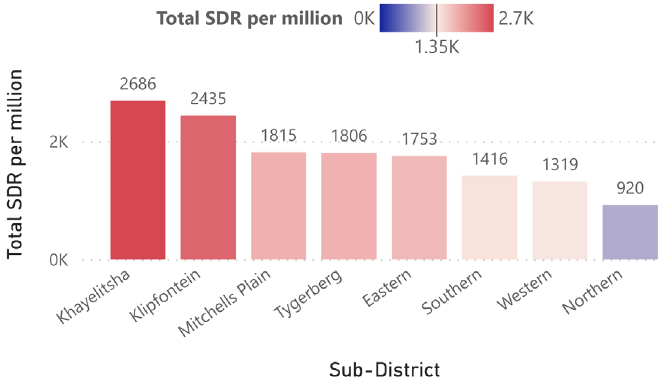
Figure 2. Total COVID-19 Standardized Death Rate (SDR) per million by sub-district. Graphic courtesy of the Western Cape Department of